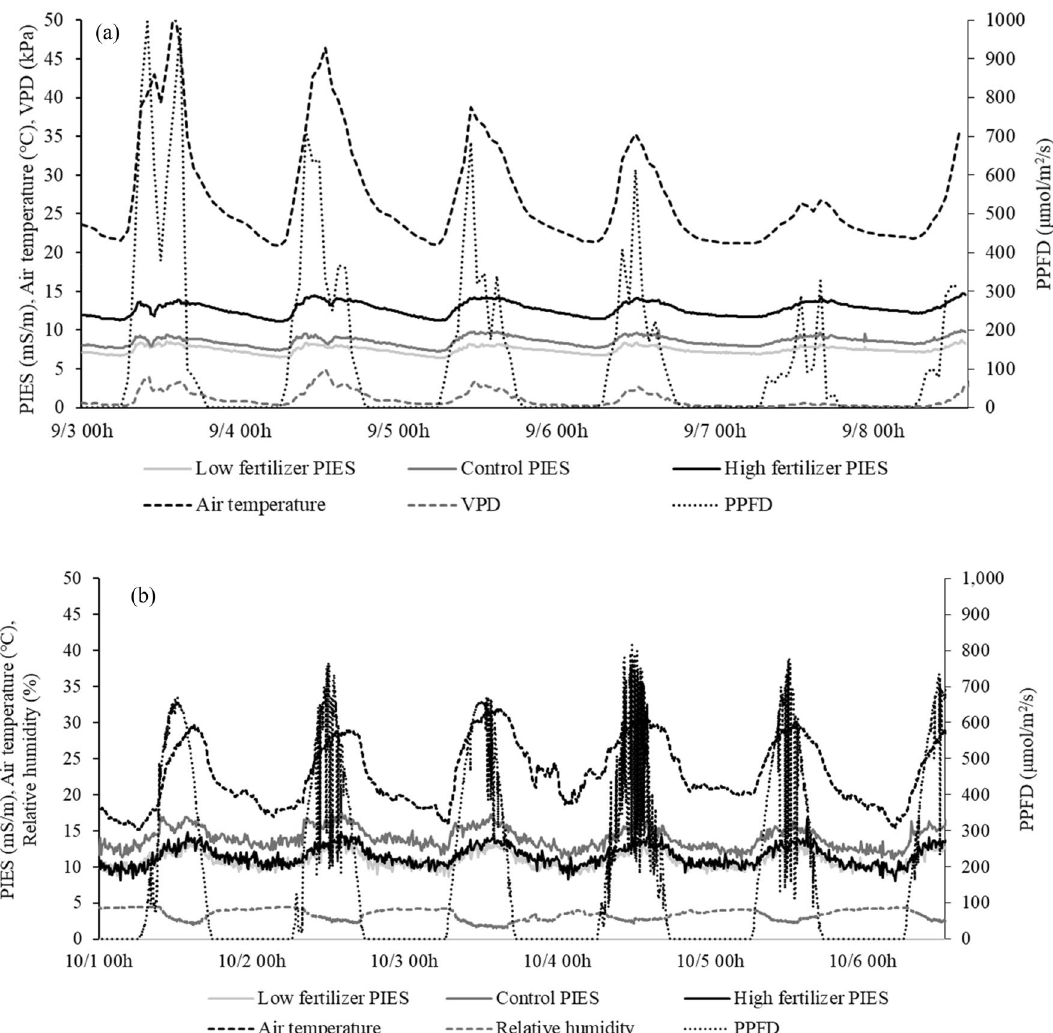
Figure 1. Plant induced electrical signal (PIES) of pepper plants according to different urea fertilizer applications in a greenhouse ( a ) and in field ( b